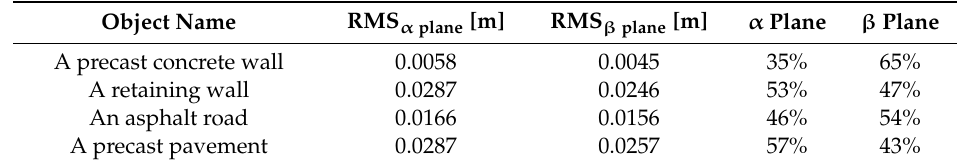
Table 1. RMS values for the α solution and β solution and percentage of points in the planes α and β , respectively.